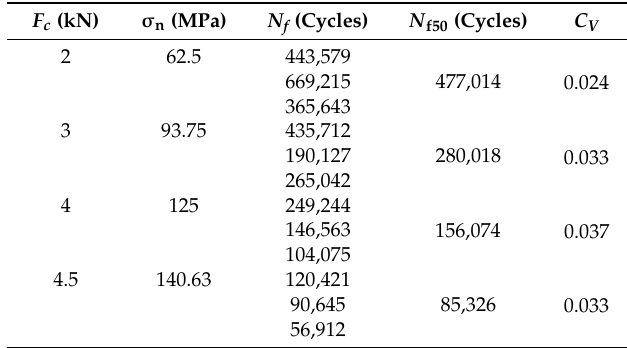
Table 5. The influence of normal stress σ n on the fretting fatigue life N f50 ( σ max = 69.17 MPa, F max = 8 kN).